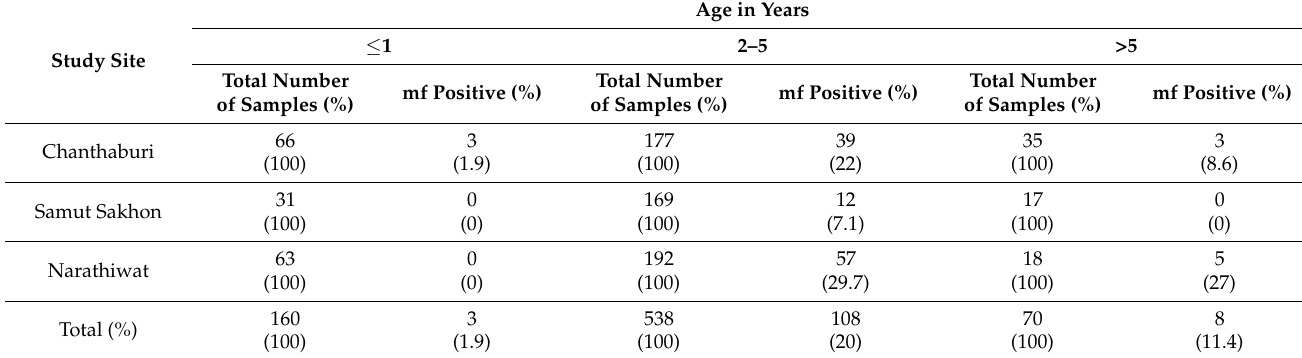
Table 2. Age distribution of 768 dogs stay in Chanthaburi, Samut Sakhon, and Narathiwat provinces, Thailand as a study population for microfilariae